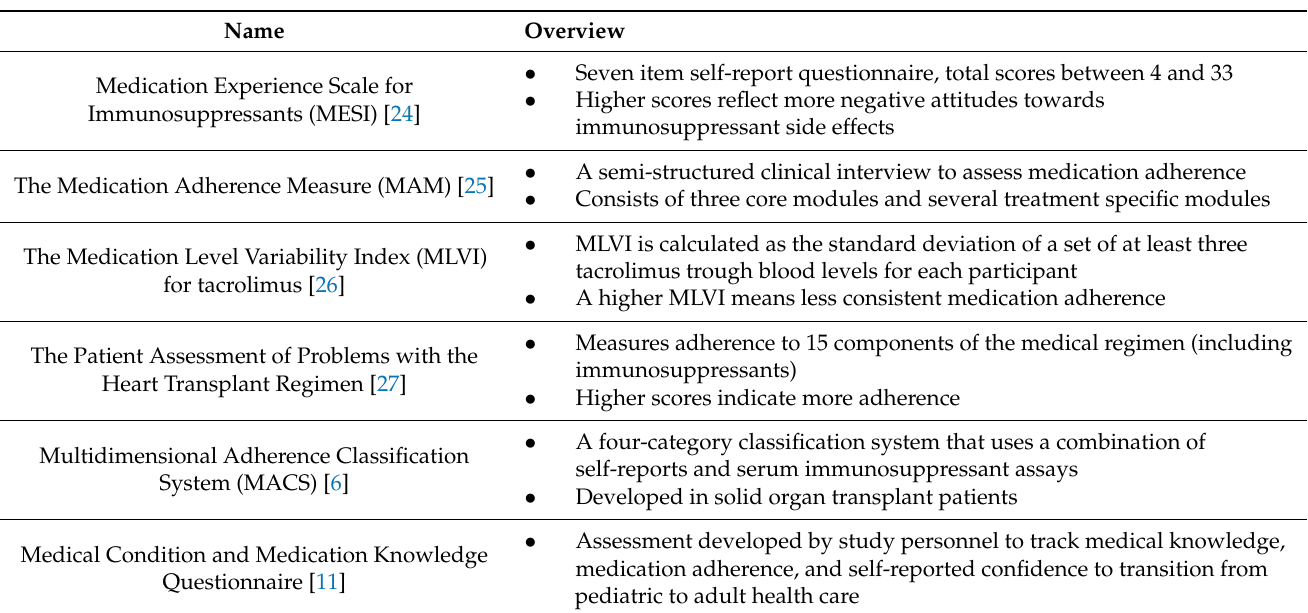
Table 2. Measures of Adherence.